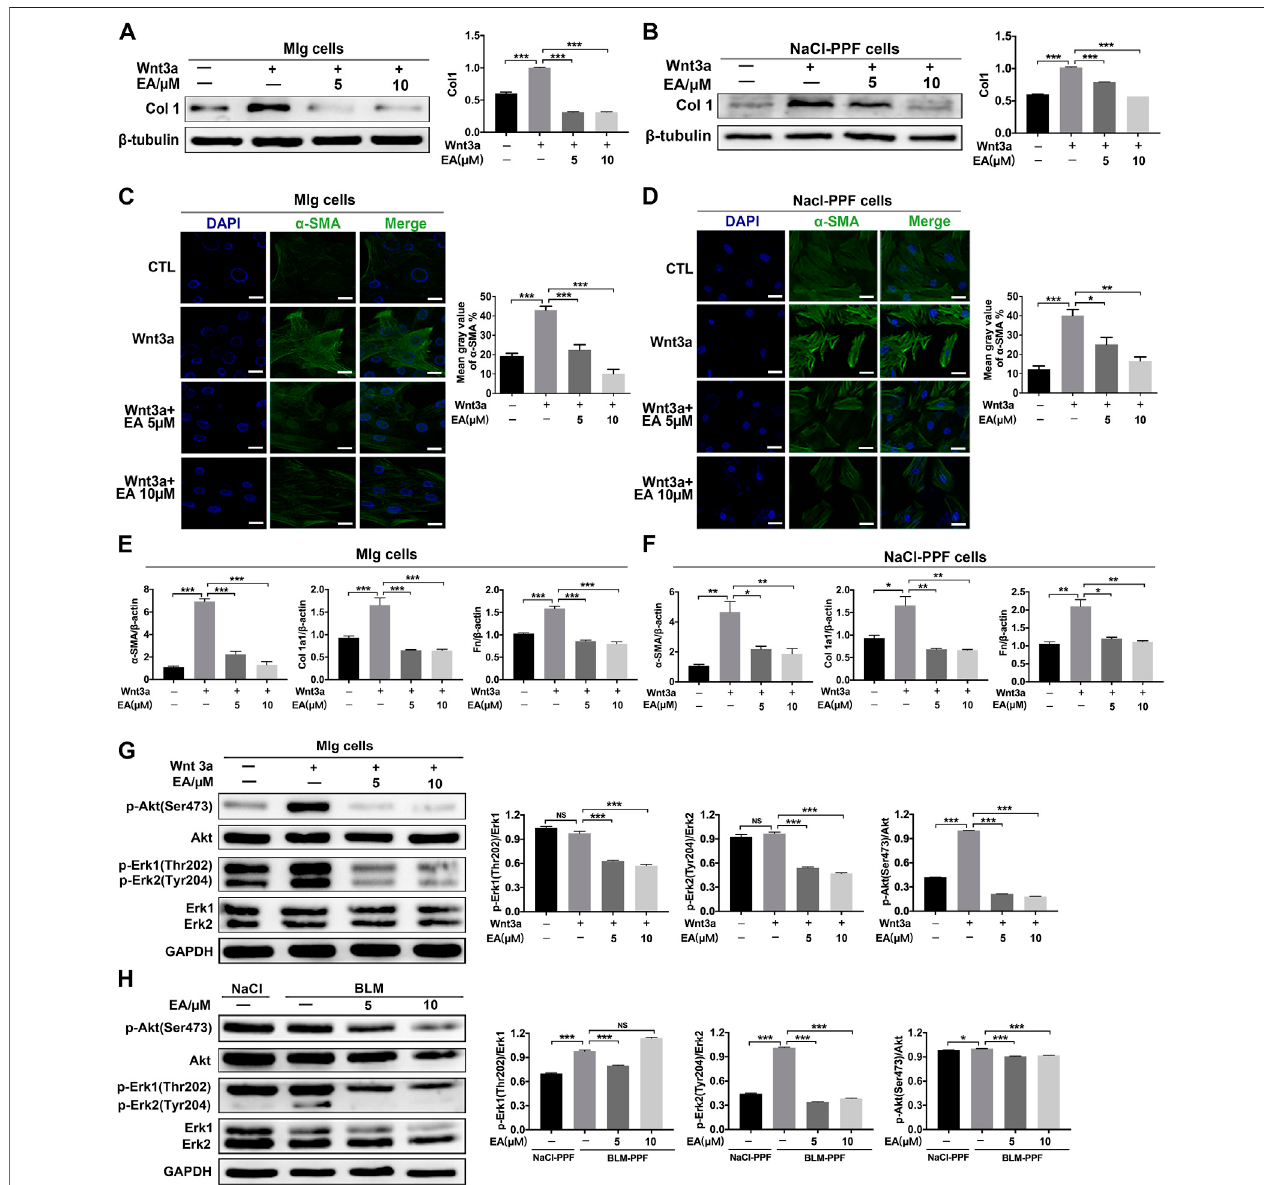
FIGURE3| EllagicaciddecreasesWnt3a-induced pulmonary fi broblasts activationand ECMaccumulation (A , B) Mlgand NaCl-PPFcellswereexposedtoWnt3a (100 ng/ml) and/or Ellagic acid (5 µM, 10 µM) 24 h to detect expression level of Col1 by using Western blot. Densitometric analyses were shown beside (C , D) Mlg and NaCl-PPFcellswereexposedtoWnt3a(100 ng/ml)and/orEllagicacid(5 µM,10 µM)24 htodetectthe α -SMAexpressionlevelbyimmuno fl uorescence,theanalysesof meangrayvaluewereshownbeside (E , F) Wnt3a(100 ng/ml)and/orEllagicacid(5 µM,10 µM)wereincubatedwithMlgandNaCl-PPFcellsfor12 h,andcelllysate was used to analyze the mRNA levels of α -SMA, Col1 and Fn by using quantitative real-time PCR( n (cid:1) 3) (G , H) Mlg and NaCl-PPF cells were exposed to Wnt3a (100 ng/ ml)and/orEllagicacid(5 µM,10 µM)for12 h,BLM-PPFcellsweretreatedwithEllagicacid(5 µM,10 µM)for12 htoevaluateproteinexpressionlevelsofp-Akt(Ser473), Akt,p-Erk1/2(Thr202/Tyr204)andErk1/2bywesternblot.Densitometricanalyseswereshownbeside.Data( Figures4A – H )aremeans ± StandardErrorofMean, n (cid:1) 3, * p < 0.05, ** p < 0.01, *** p < 0.001, and NS: nonsigni fi cant (one-way ANOVA). β -tubulin or GAPDH was used as a loading control.